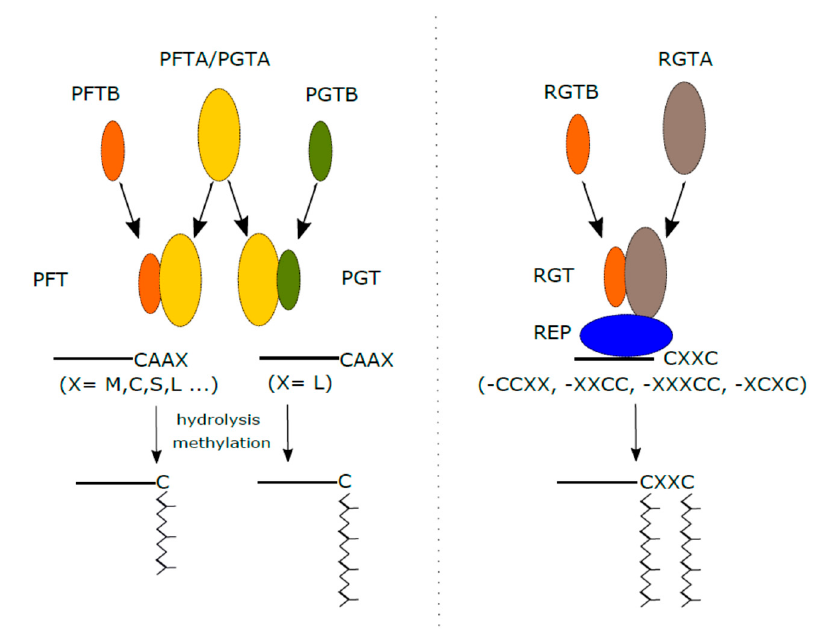
Figure 1. Protein prenylation in plants. The left side of the picture shows the structure of CAAX protein prenyl transferases (PFT and PGT), their preference for a C-terminal motif, processing of the prenylated protein, and a final form of the prenylated substrate. The right side shows the structure of RGT, involvement of the REP protein, possible C-terminal motifs, and a final form of the prenylated RAB GTPase.